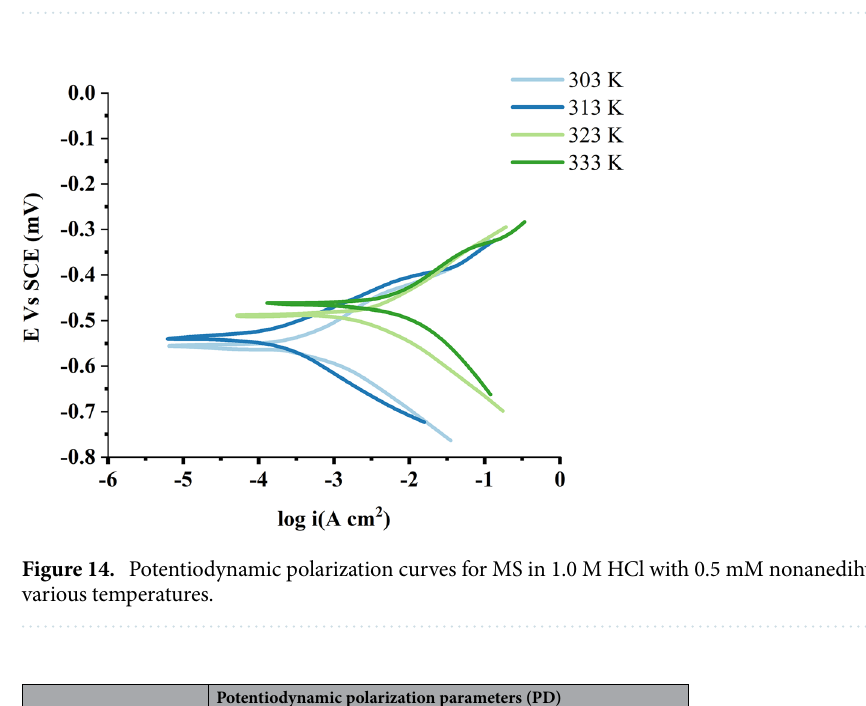
Inhibitor conc. (mM)